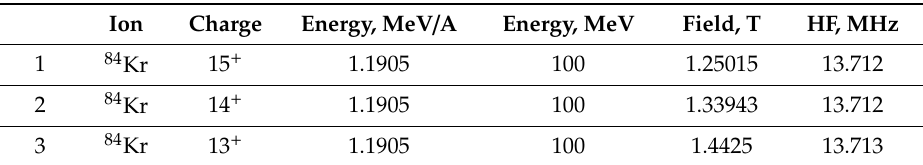
Table 1. Parameters of 84 Kr ion